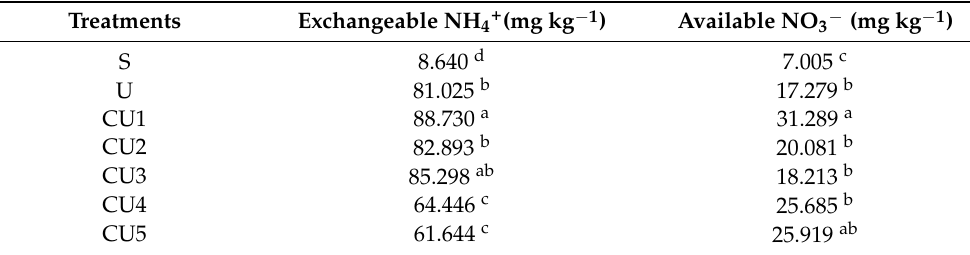
Table 5. The effects of uncoated urea and coated urea on exchangeable ammonium and available nitrate.